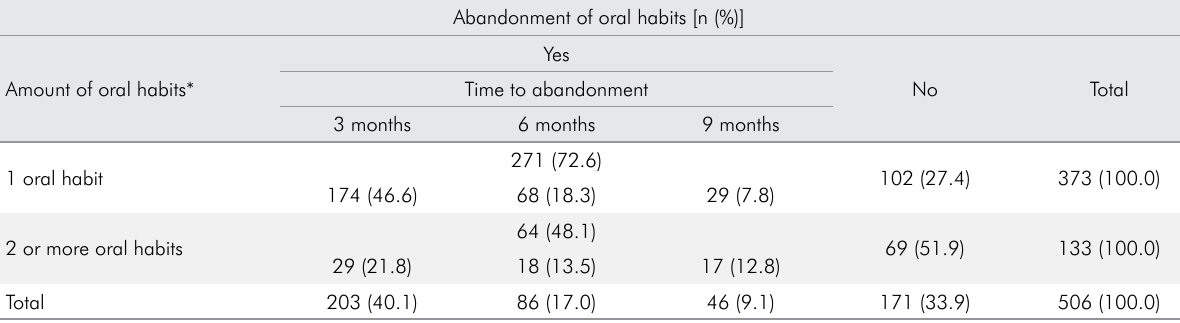
Table 3. Distribution of the number of oral habits in relation to the abandonment of oral habits. Abandonment of oral habits [n